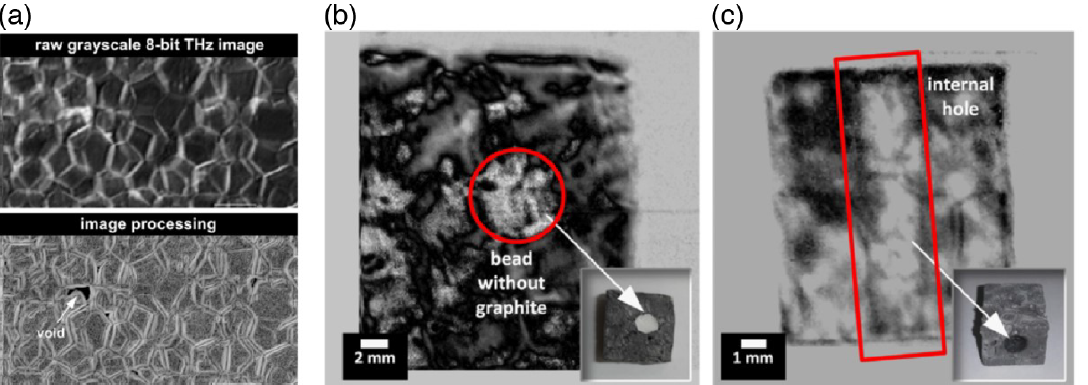
Figure 17. ( a ) signal processing for particle analysis of THz image determining the voids within a polymer foam [176]. Detection of imperfections ( b ) and internal structures ( c ) by THz imaging [175]. Reprinted from Ref. [176] and Ref. [175] with permission from